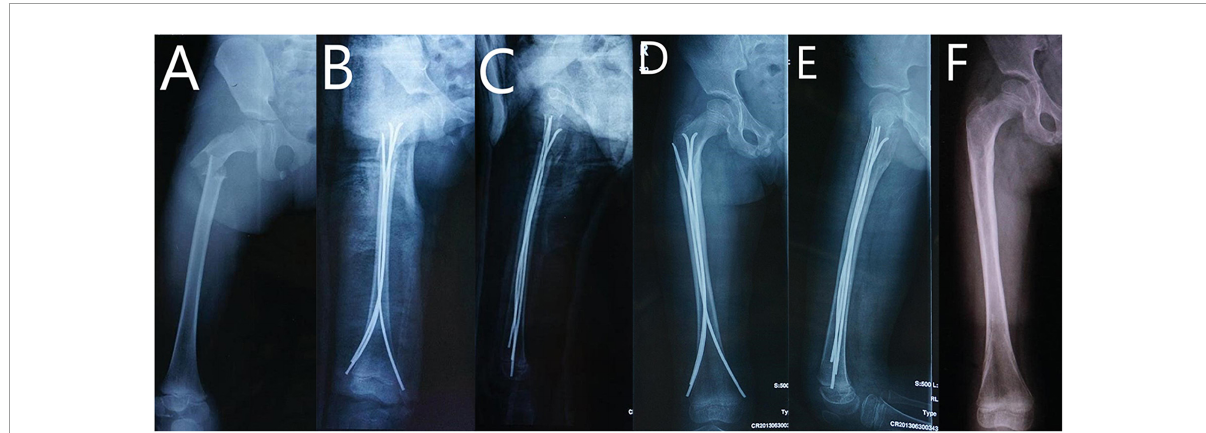
FIGURE1 9 year-old girl with right subtrochanteric fracture treated with triple ESINs. (A) AP view of femur before surgery. (B) AP view of femur after surgery. (C) Lateral view of femur after surgery. (D) AP view of femur at 6th month follow-up. (E) Lateral view of femur at 6th month follow-up. (F) AP view of femur after implant removal.